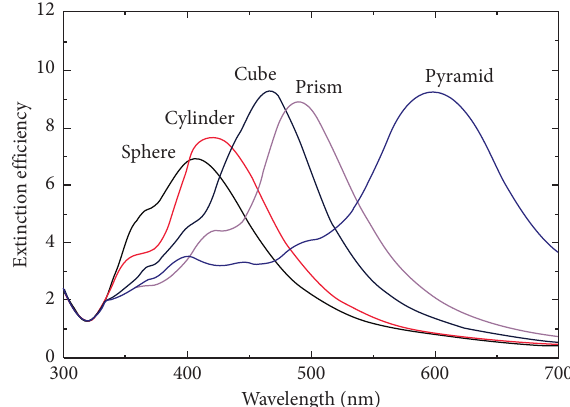
Figure 10: Efficiency of extinction of silver nanoparticles with different forms [15].